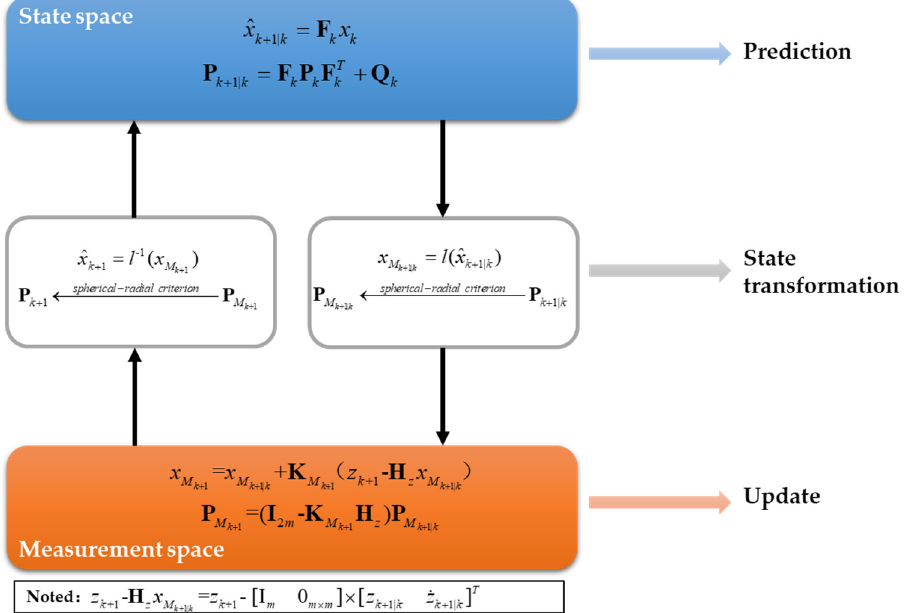
Figure 2. The algorithm flow of the MSKF.